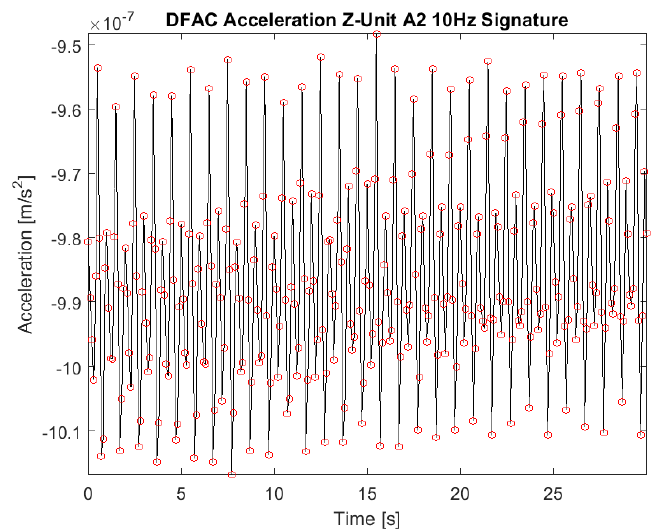
Figure 1. The 10 Hz read out of a high sensitivity axis of the GOCE accelerometer A2. The dominant signature is a result of the heater switching. The heaters are connected in series in three lines. Every line switches every second, as the heaters are pulse modulated. The time between switching of two different lines is 1/3 s.